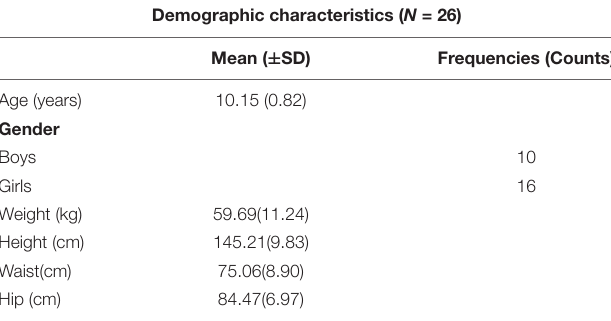
TABLE 1 | Participant baseline demographic